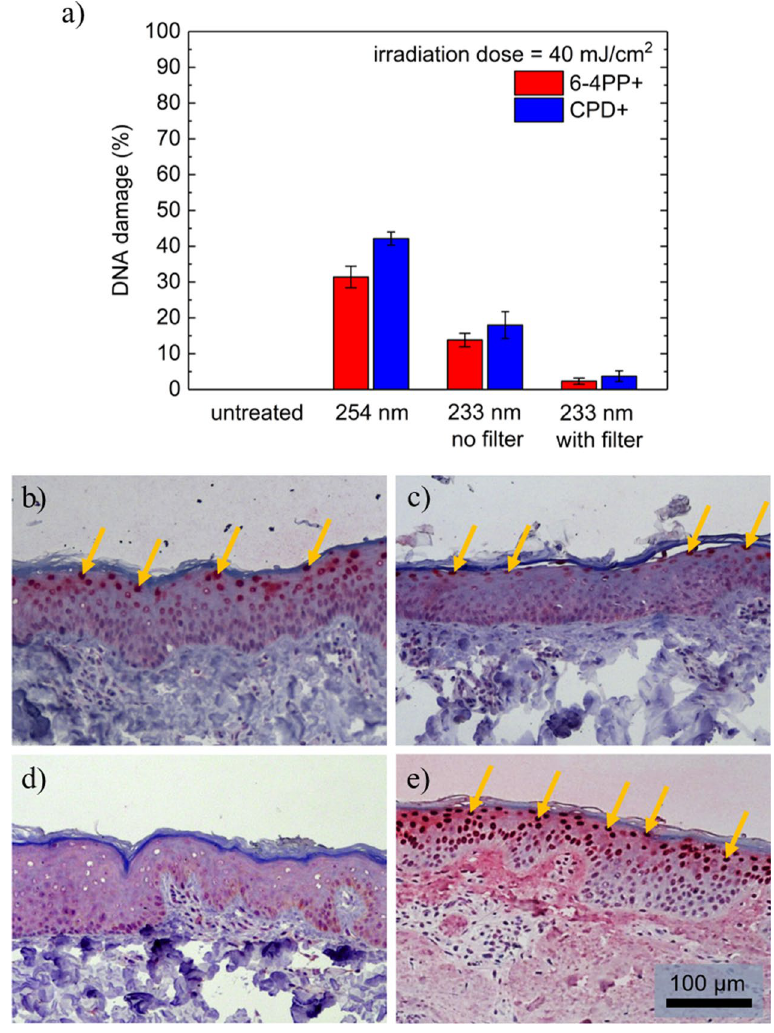
Figure 4. ( a ) DNA damage for irradiated porcine skin using 254 nm and 233 nm light sources with 40 mJ/cm 2 . Untreated skin served as control. The mean values of the epidermal DNA damage in % are calculated from at least three experiments and the error bars show the standard error of the mean. ( b )–( e ) Histologic images HE and CPD stained porcine skin after irradiation using the far-UVC LED irradiation system without ( c ) and with filter ( d ), in comparison, untreated skin ( e ) and skin after irradiation with near-UVC radiation at 254 nm ( f ). Arrows mark CPD positive cells. The scale bar is 100